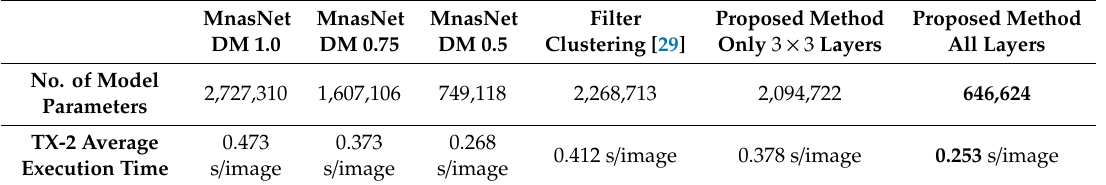
Table 5. Comparison between the number of parameters of the pig-anomaly detector model and the